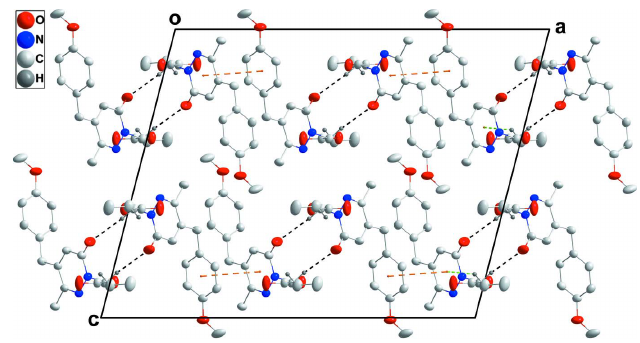
Figure 3 Packing viewed along the b -axis direction with the highlighted inter- molecular interactions shown as in Fig. 2.